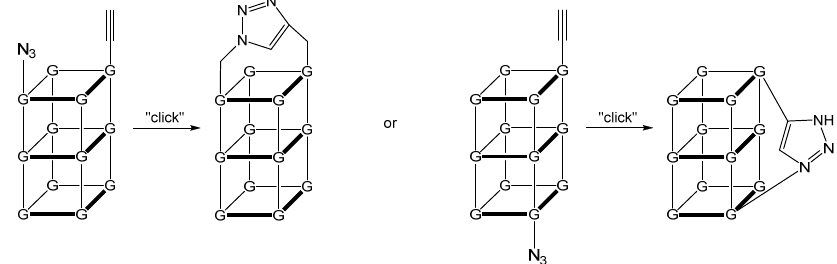
Scheme 17. Illustrative depiction of the use of click chemistry in